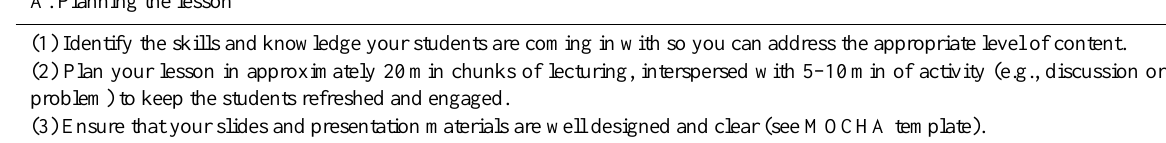
Table 1. The ABCD of lesson design